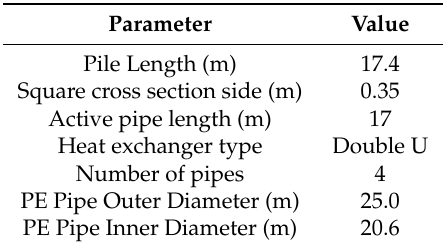
Table 1. Geometry of the tested energy pile.